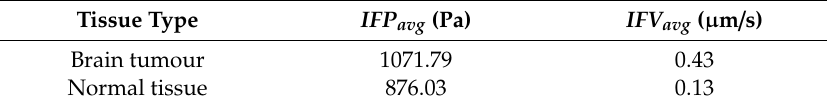
Table 3. Predicted interstitial fluid